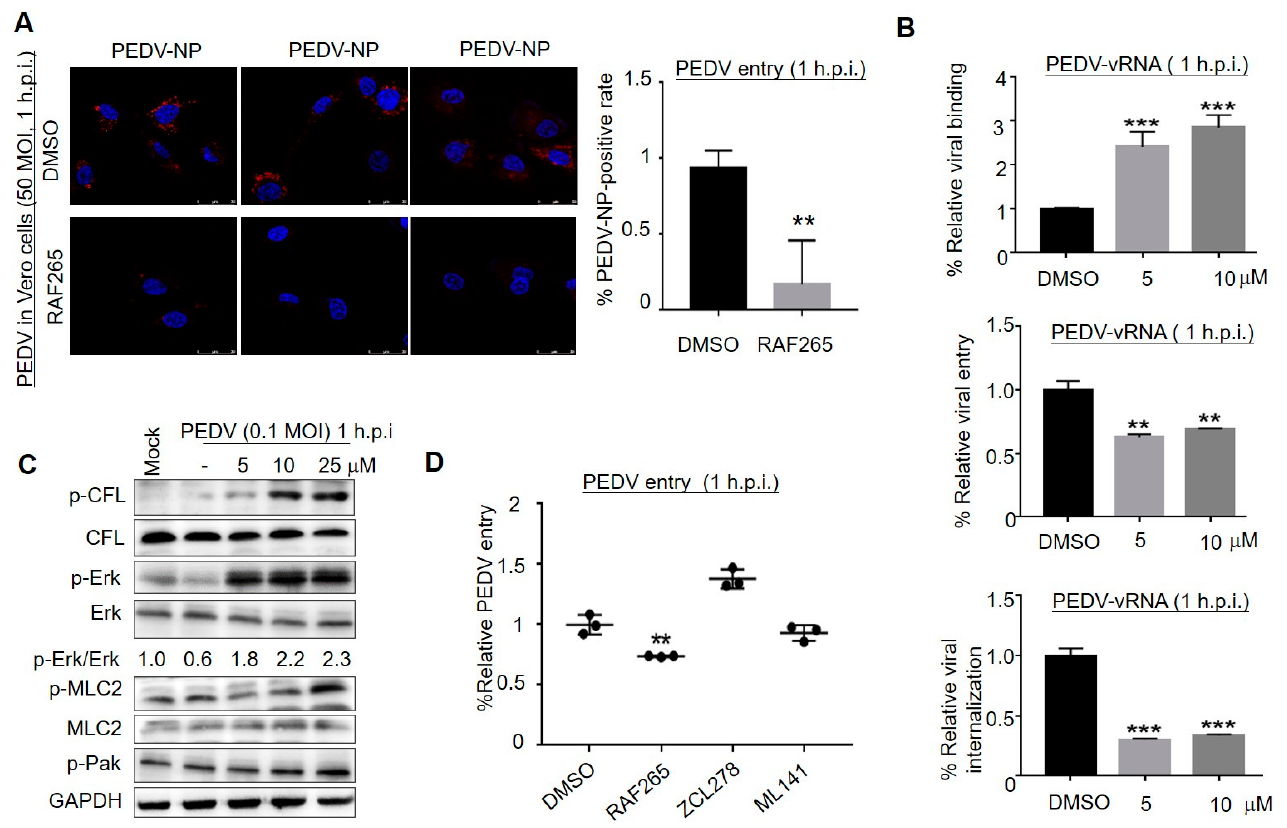
Figure 2. RAF265-mediated cytoskeleton arrangement involved in the early events of viral infection. ( A ) Infected cells were treated with RAF265 for 1 h at 37 °C, fixed, permeabilized, and stained for DAPI (blue) and PEDV NP (red). Viral entry was evaluated by confocal fluorescence microscopy magnification 200×. The experiments were performed three times and from 1 random horizon in each experiment. ( B ) Vero cells were infected with PEDV in the presence of DMSO or RAF265 for 1 h at 4 °C, washed three times with cold PBS, and then viral RNA was extracted for RT-PCR assay (top). Vero cells were infected with PEDV in the presence of DMSO or RAF265 for 1 h at 37 °C, washed three times with cold PBS. Viral RNA was extracted for RT-PCR assay (middle). Vero cells were infected with PEDV for 1 h at 4 °C, washed three times with cold PBS, and then treated with indicated concentrations of RAF265 for 1 h at 37 °C. Viral RNA was extracted for RT-PCR assay (bottom). ( C ) Vero cells were infected with PEDV at 0.1 MOI in the presence of RAF265 at different concentrations for 1 h. Cells were harvested for WB analysis with indicated antibodies. ( D ) Infected cells were co-treated with RAF265, ZCL278, or ML141 for 1 h at 37 °C and washed with cold PBS. Viral genome was extracted for qRT-PCR. h.p.i, hours post-infection; MOI, multiplicity of infection. Significance was evaluated using one-way ANOVA (mean ± SEM, n = 3). ** p ≤ 0.01; *** p ≤ 0.001.